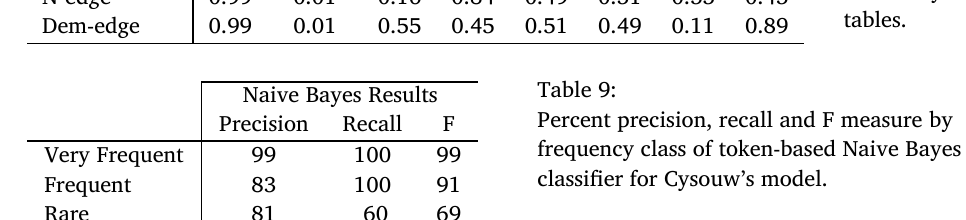
Cysouw’s joint probability Naive Bayes